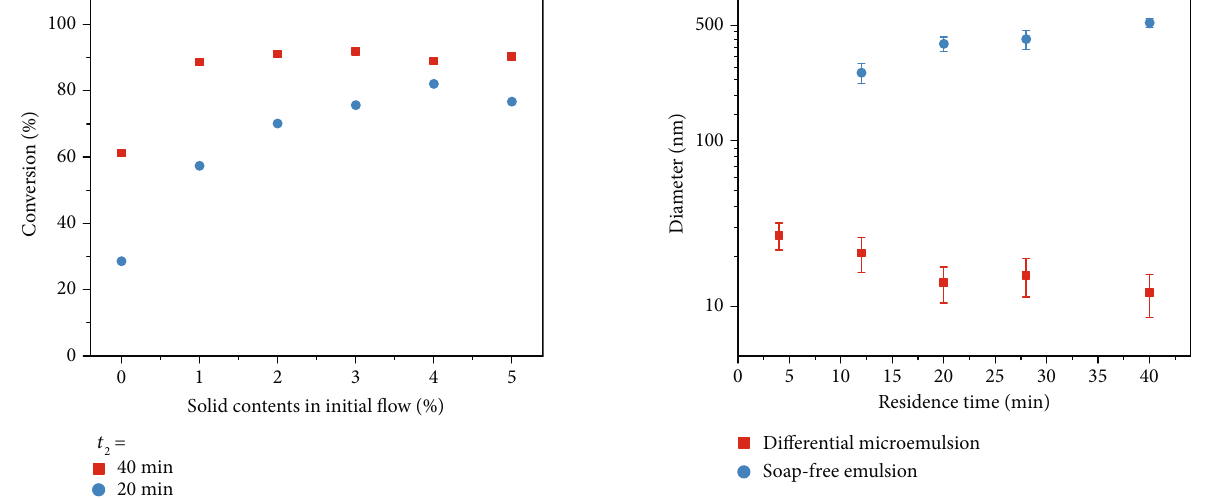
Figure 11: Number-average diameter of the latex particles versus residence time pro fi les for di ff erential microemulsion polymerization and soap-free emulsion